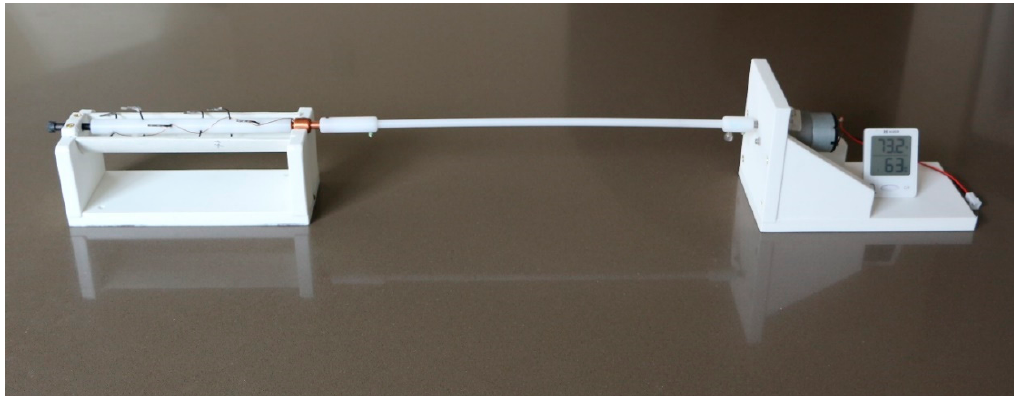
Figure A4. Photograph of the bath, a saguaro electrode in the bath and the electrode drive moto. The pictured assembly is approximately 80 cm long (32 inches). A humidity meter is sitting on the drive motor stand.